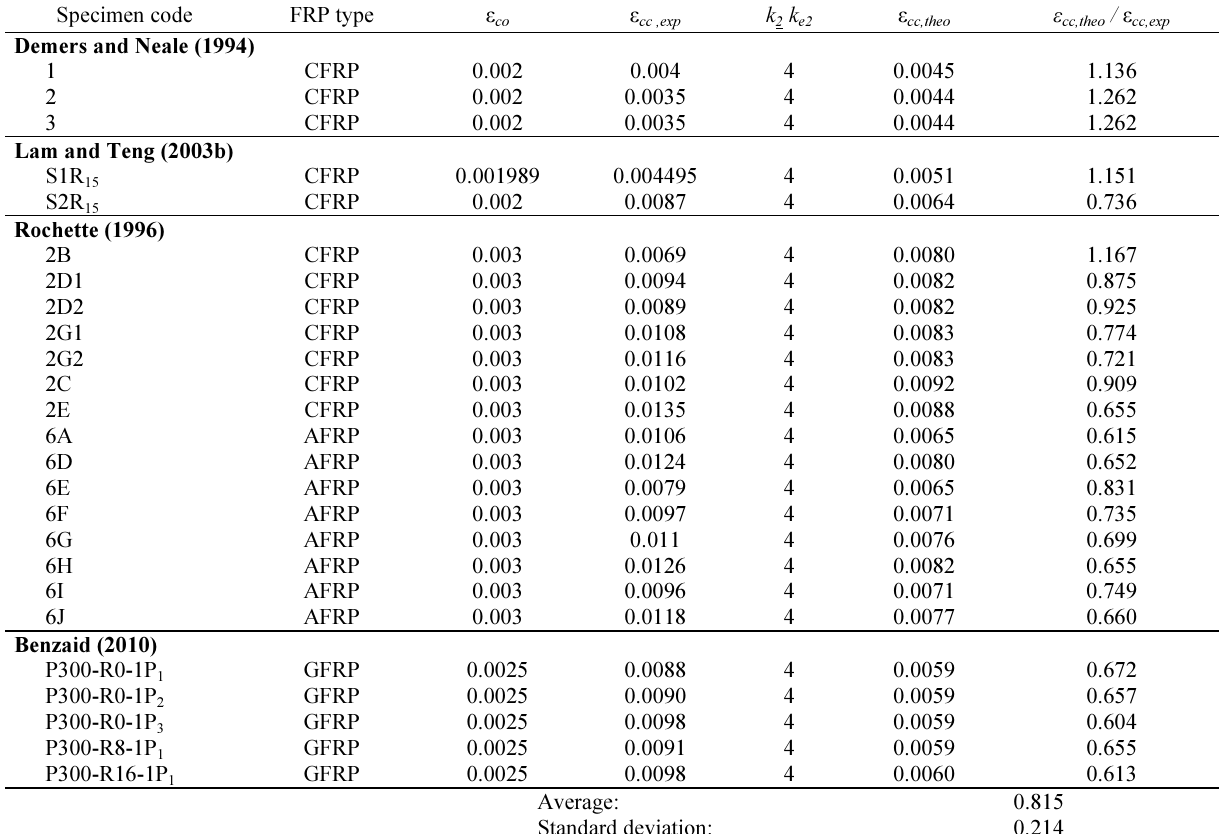
Table 10. Performance of proposed model: axial